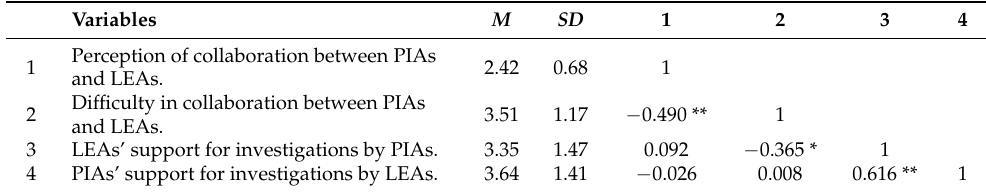
Table 3. Correlation of scales assessing perceptions of collaboration between PIAs and LEAs about human